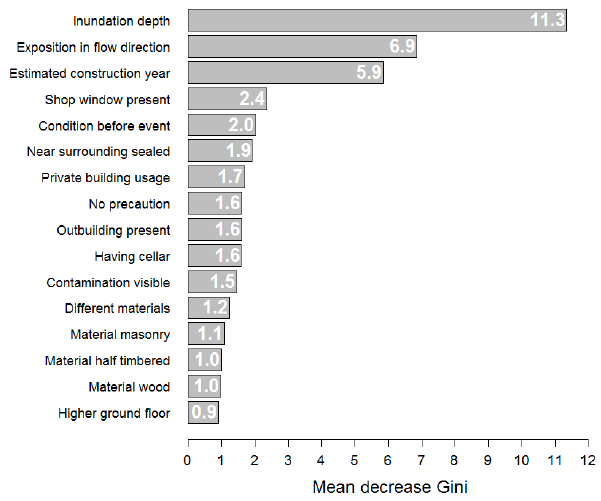
Figure 1. Random forest feature importance (mean decrease Gini) for the response variable damage grade.